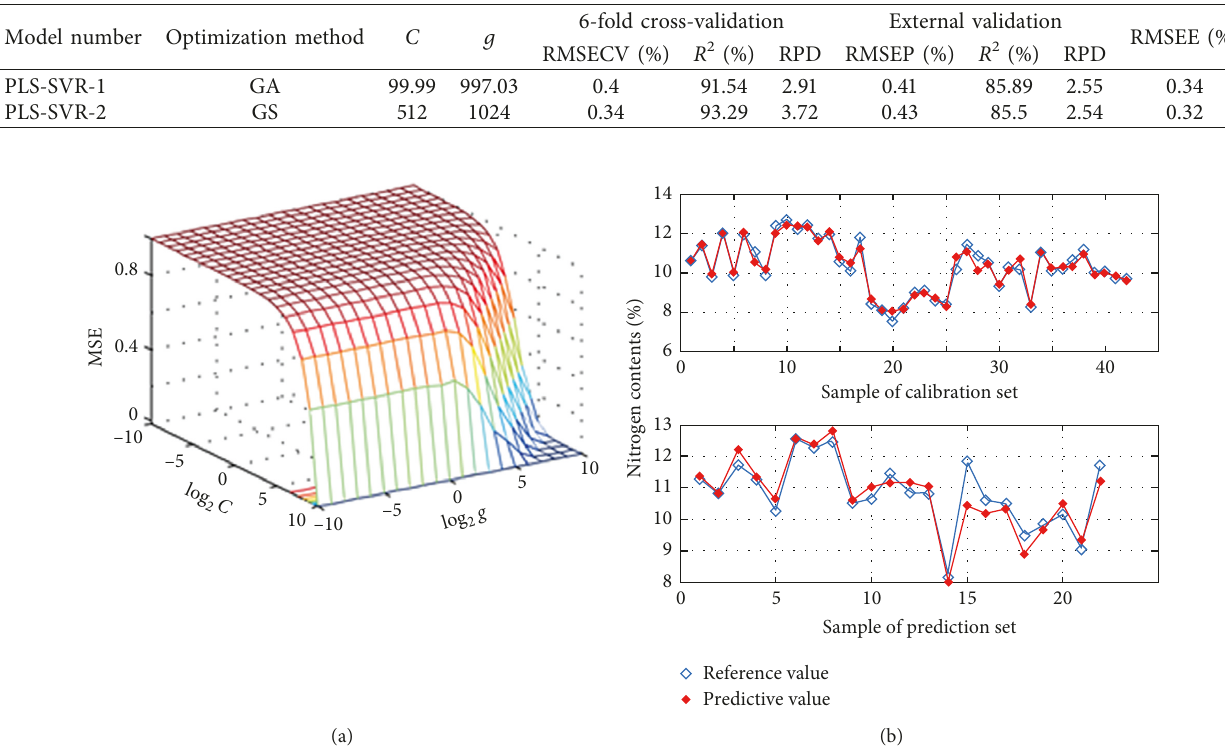
Figure 6: Parameter optimization (a) and predictive results (b) of the PLS-SVR-2 model.